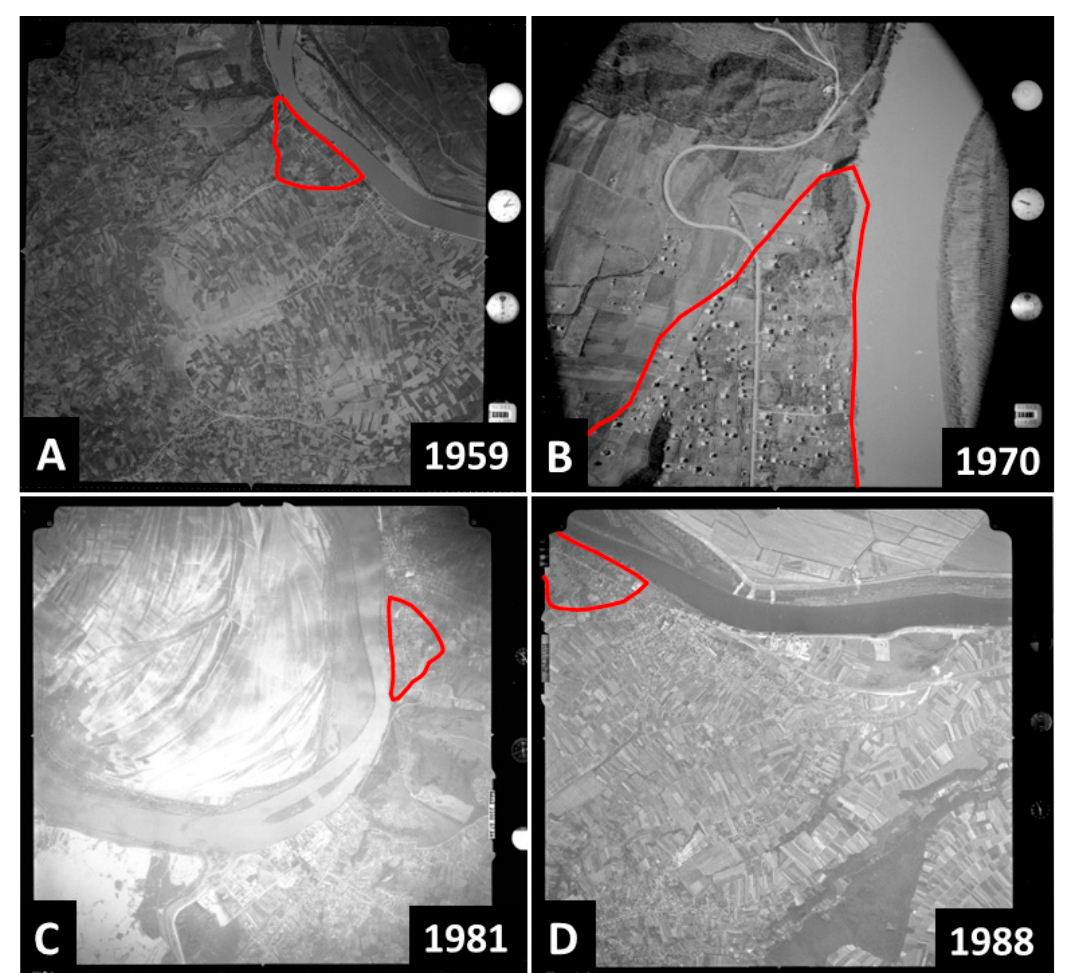
Figure 3. Aerial photographs of the Umka area from different periods, with the boundaries of the “Umka” landslide plotted (red line). ( A ) Aerial images from 1959 that can be used for photogram- metric processing and analysis. ( B ) Aerial images from 1970 that have an excellent possibility for photogrammetric processing and analysis. ( C ) Aerial images from 1981 that have limited application for photogrammetric processing and analysis, due to the high lighting values of certain images from the series. ( D ) Aerial photographs from 1988 with very limited possibility for photogrammetric pro- cessing and analysis, due to the unfavorable position of landslide on the overlay of the photographs. Table 2. The possibility of applying archival digital aerial photographs for photogrammetric and processing and analysis of the “Umka” landslide (MapSoft-Belgrade). The sets of imagery that were used during the creation of this paper are marked with